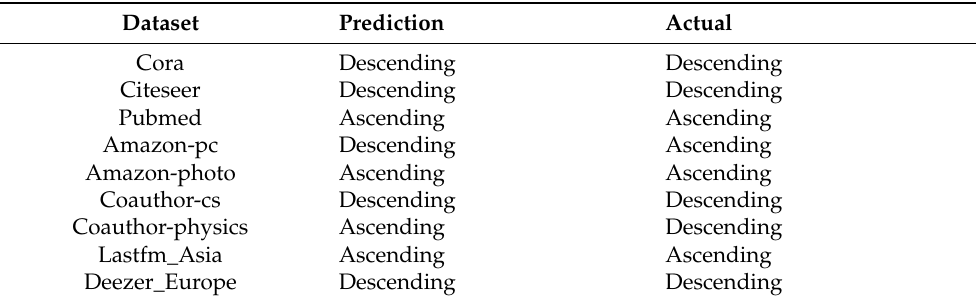
Table 2. The sampling direction is predicted with a high accuracy by studying the skewness of the homogeneity connectivity distribution. The misclassifications are likely caused by a lack of node importance evaluators, which are robust to graph topology. Dataset Prediction Actual Cora